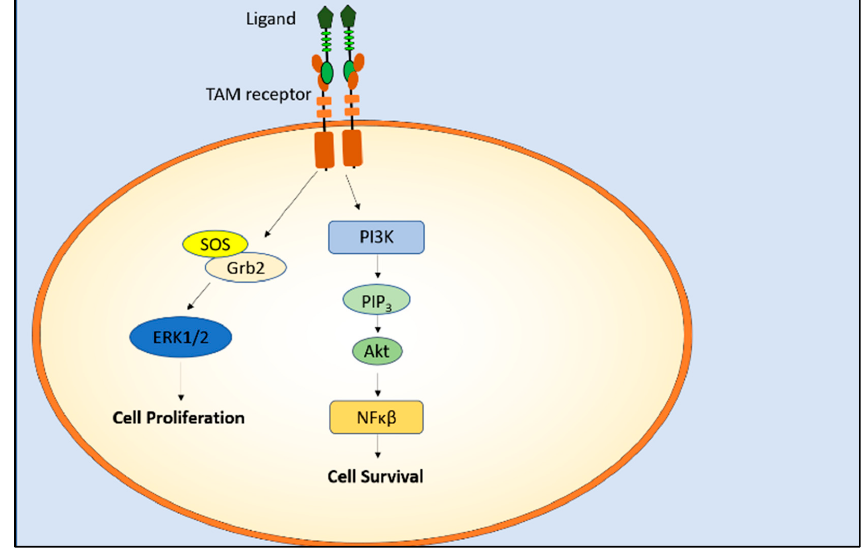
Figure 3. TAM receptor activation results in cell proliferation and survival that are essential for normal neural development. Activation of the PI3K/Akt/NF- κ B pathway leads to cell survival, while the activation of SOS/ growth factor receptor-bound protein (Grb2) / extracellular-signal-regulated kinase (ERK) pathway leads to cell proliferation. NF- κ B: nuclear factor κ -light-chain-enhancer of activated B cells.